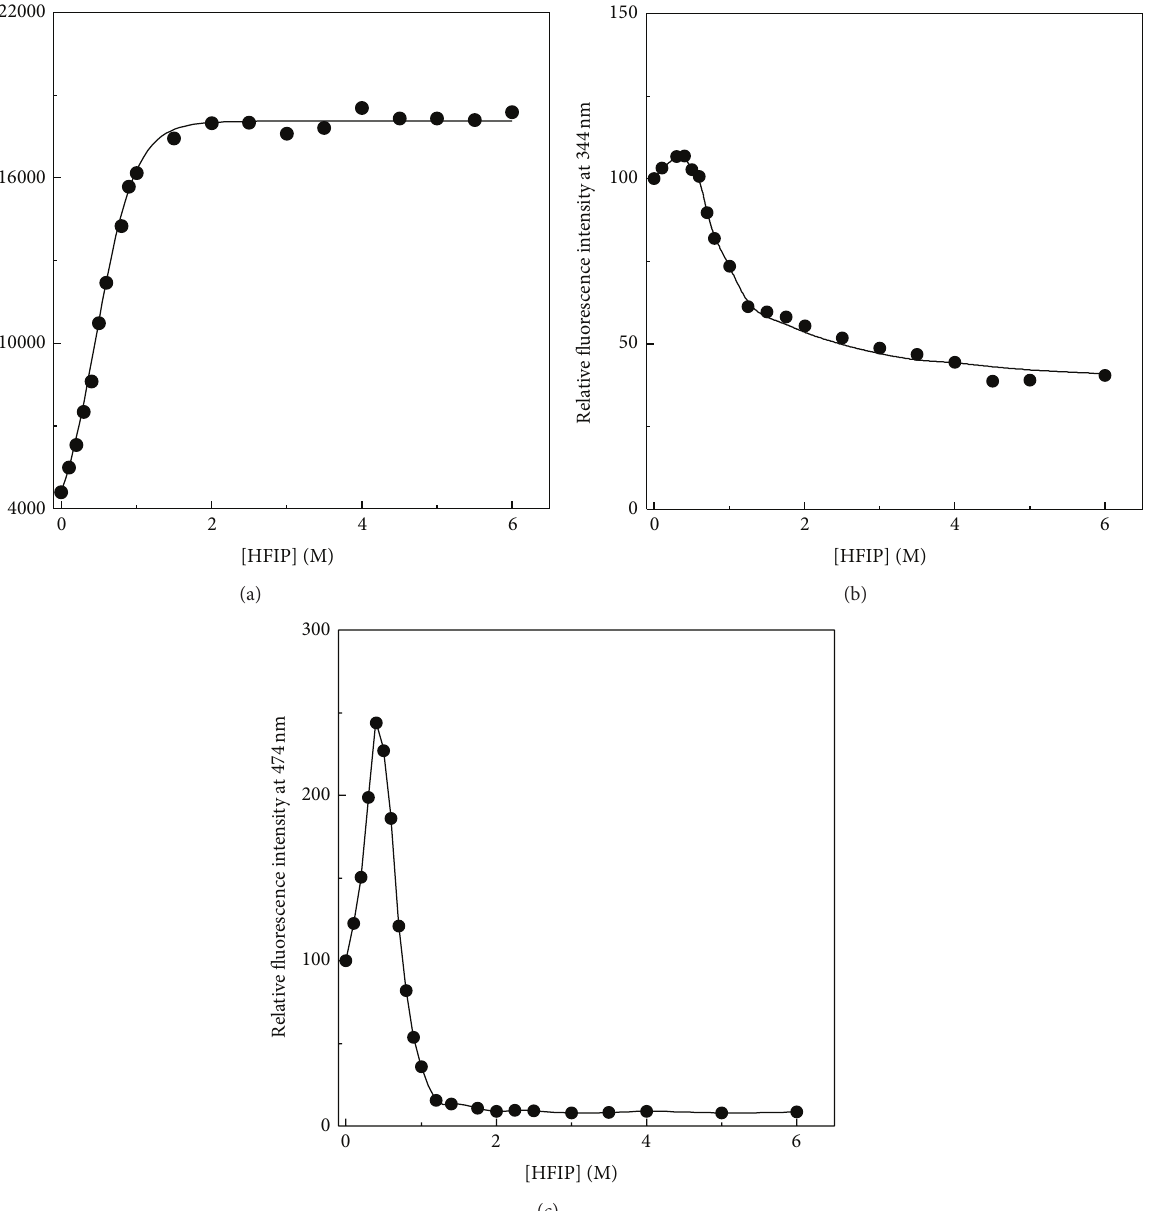
Figure 1: Effect of increasing HFIP concentrations on the spectral characteristics of the acid-denatured BLA at pH 2.0 and 25 ∘ C, as monitored measurements, (b) intrinsic fluorescence measurements at 344 nm upon excitation at 280 nm, and (c) ANS fluorescence by (a) MRE 222 nm measurements at 474 nm upon excitation at 380